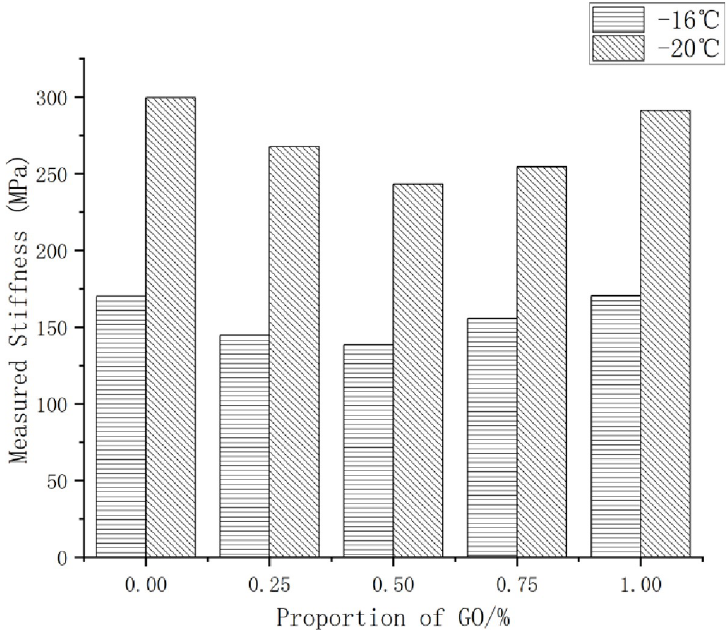
Fig 9. The influences of the GO content on the low-temperature cracking parameters of the GO/TPU/SBS- modified asphalt. (a) Effect on creep stiffness. (b) Effect on creep rate.